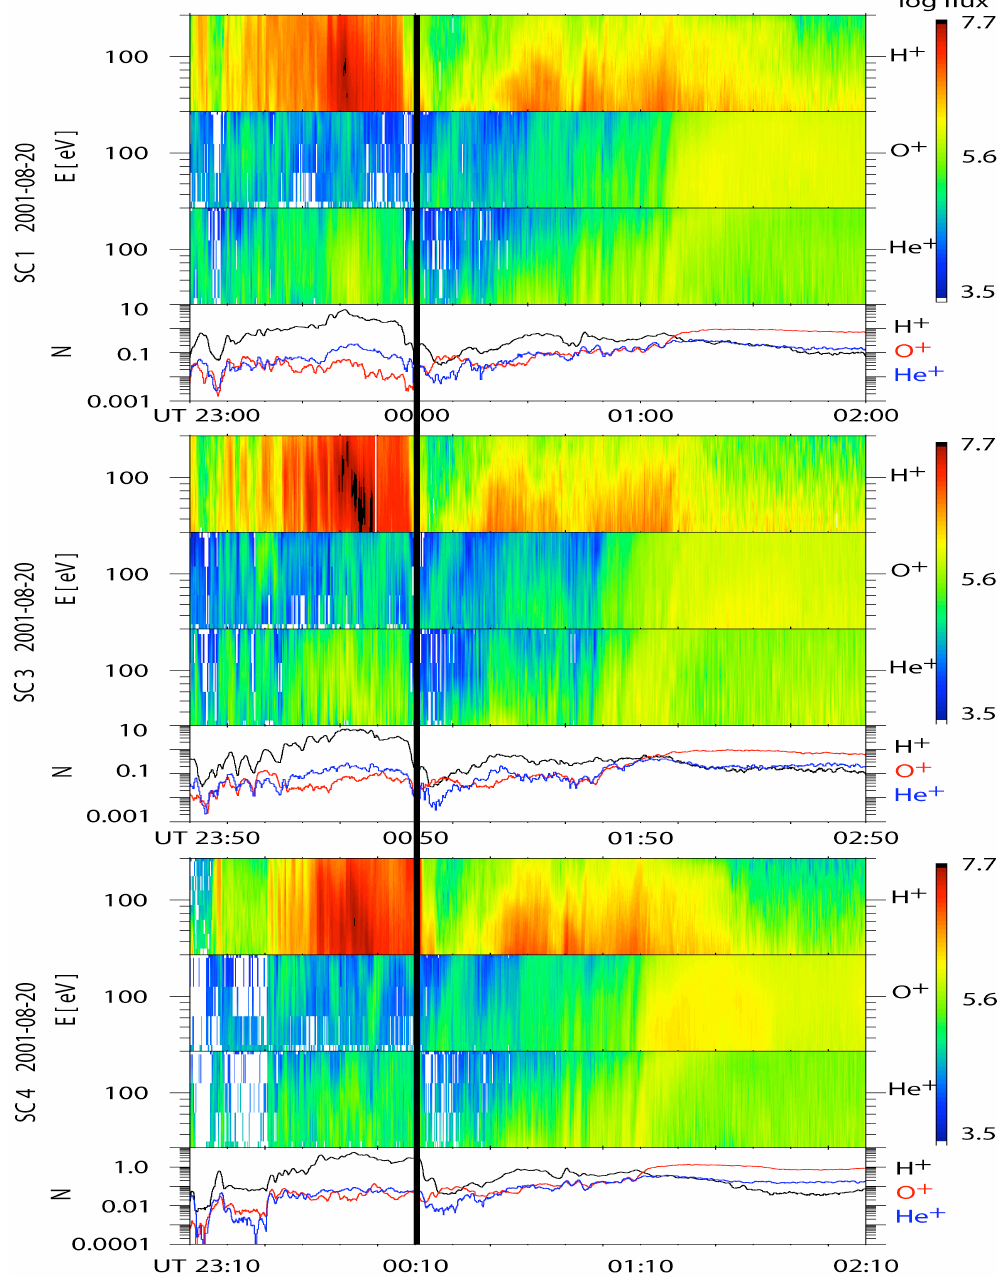
Figure 3: H + , O + and He + energy-time spectrograms in [(cm 2 s sr) -1 ] for August 21, 2001 in the energy range of 0.04 keV to 0.2 keV. The spectrograms and number density in [cm -3 ] plots are time-shifted for the Cluster spacecraft, SC 3 and SC 4 compare to SC 1. The black line indicates the same energy-time dispersed signature for O + .